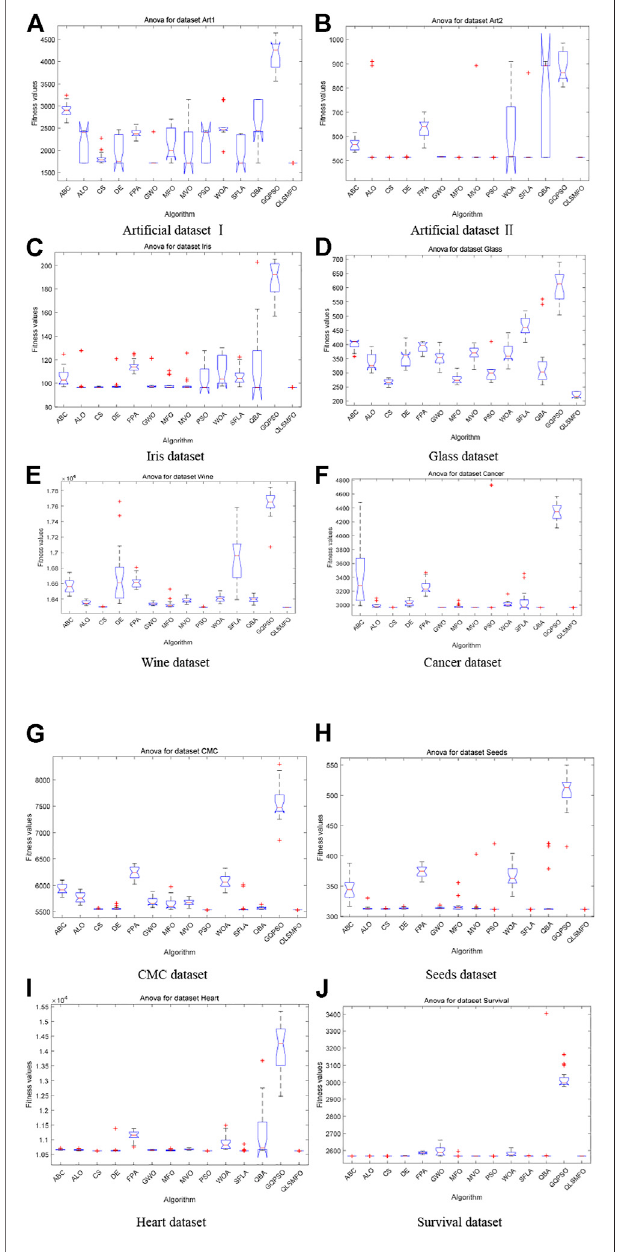
FIGURE 6 | ANOVA simulation results of all algorithms on the 10 datasets. (A) Arti fi cial Dataset I. (B) Arti fi cial Dataset II. (C) Iris dataset. (D)